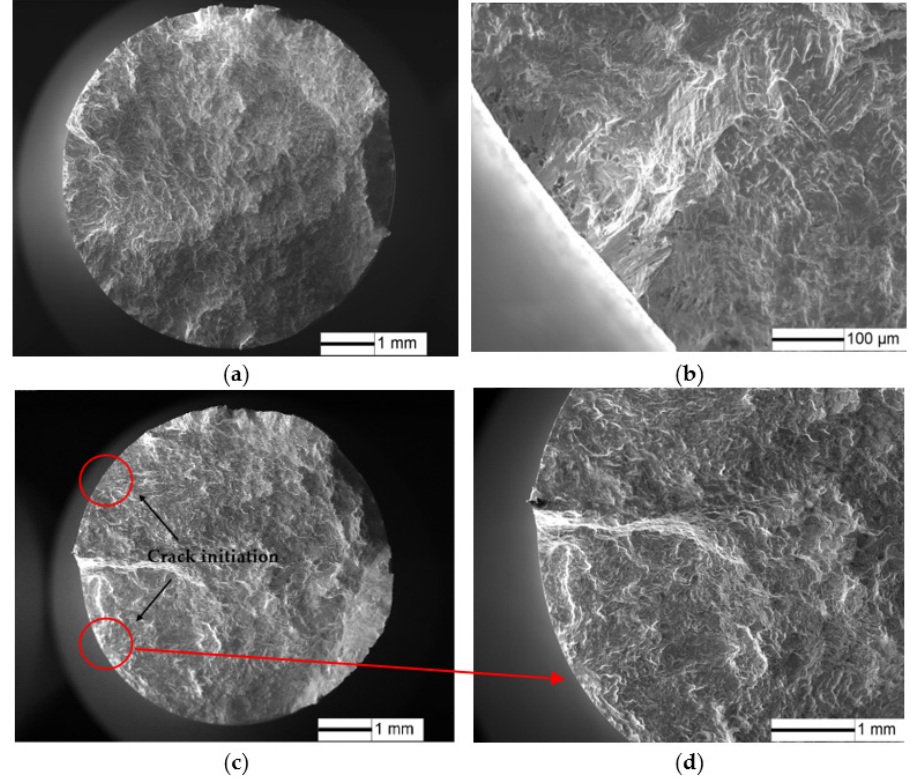
Figure 11. Typical morphology of low cycle fatigue fracture: ( a , b ) Δ ε t = 2.0%, N f = 1302 cycles; ( c , d ) ∆ ε t = 1.4%, N f = 7998 Δ ε t = 1.4%, N f = 7998 cycles. ( c , d )